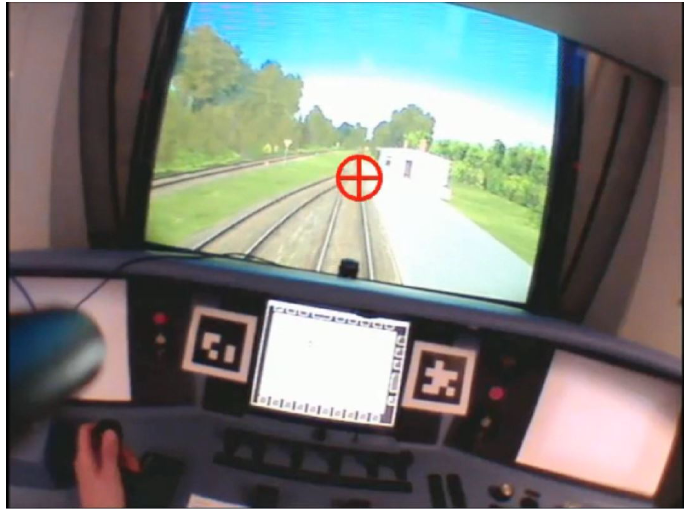
Figure 6: Eye movements of the train driver. The red cursor marks the attention